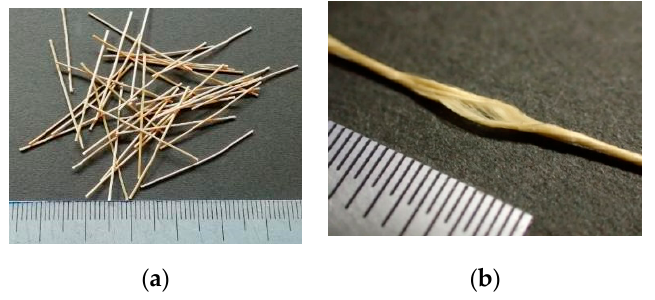
Figure 1. Visual appearance of used aramid fiber: ( a ) chopped aramid fibers for mixing fiber-reinforced cementitious composite (FRCC) and ( b ) Condition of bundling of yarns.